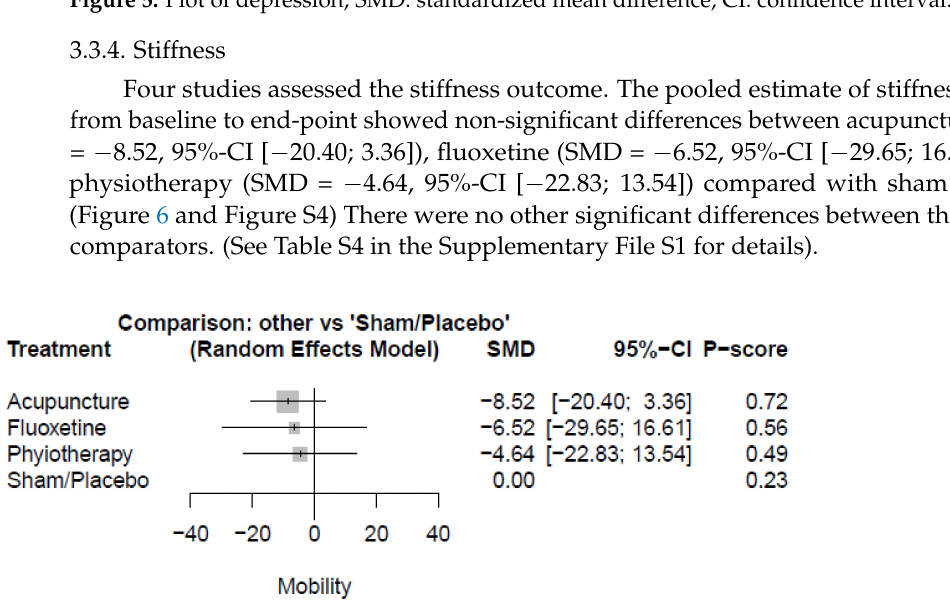
Figure 5. Plot of depression; SMD: standardized mean difference, CI: confidence interval.